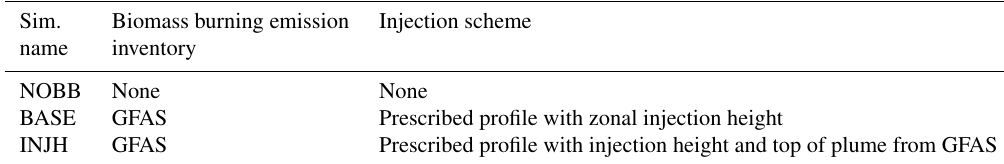
Table 2. Simulation description summary. Sim.